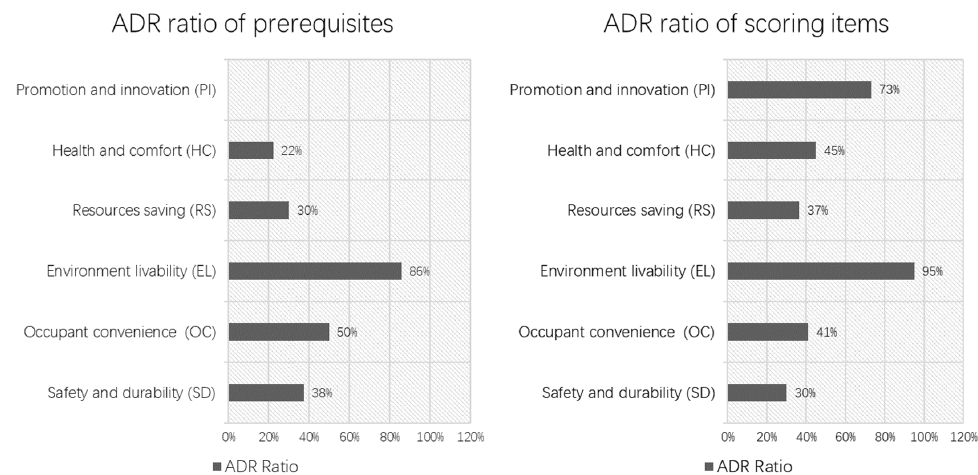
Figure A2. Breakdown of the number of prerequisites, the point of scoring items, and ADR ratios in